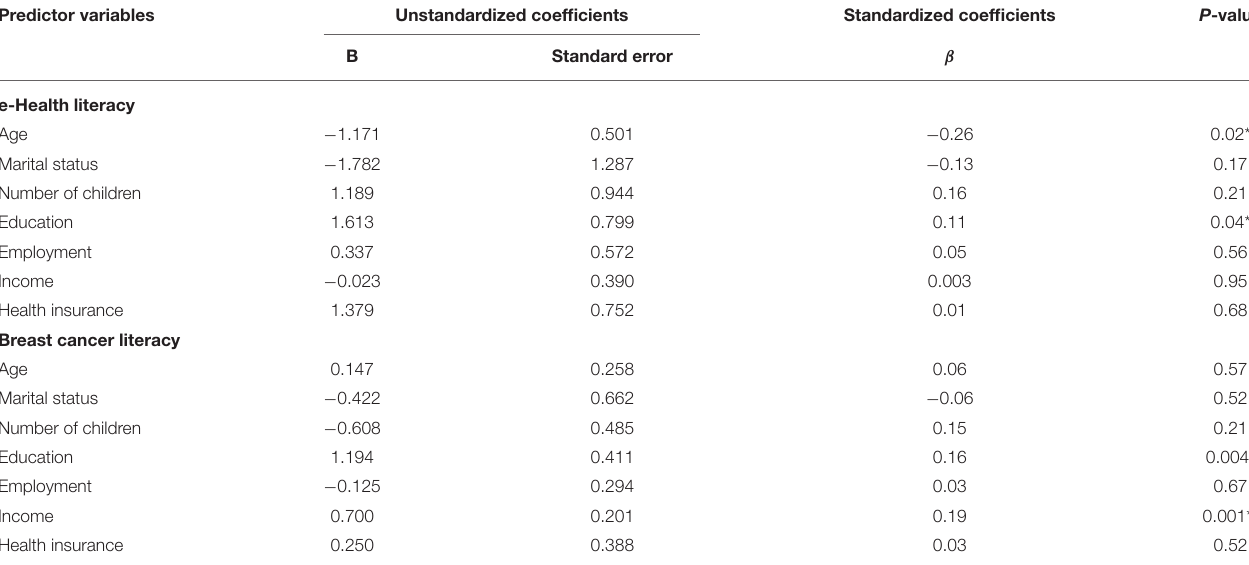
TABLE 4 | Multiple linear regression for e-Health literacy and breast cancer literacy ( N =